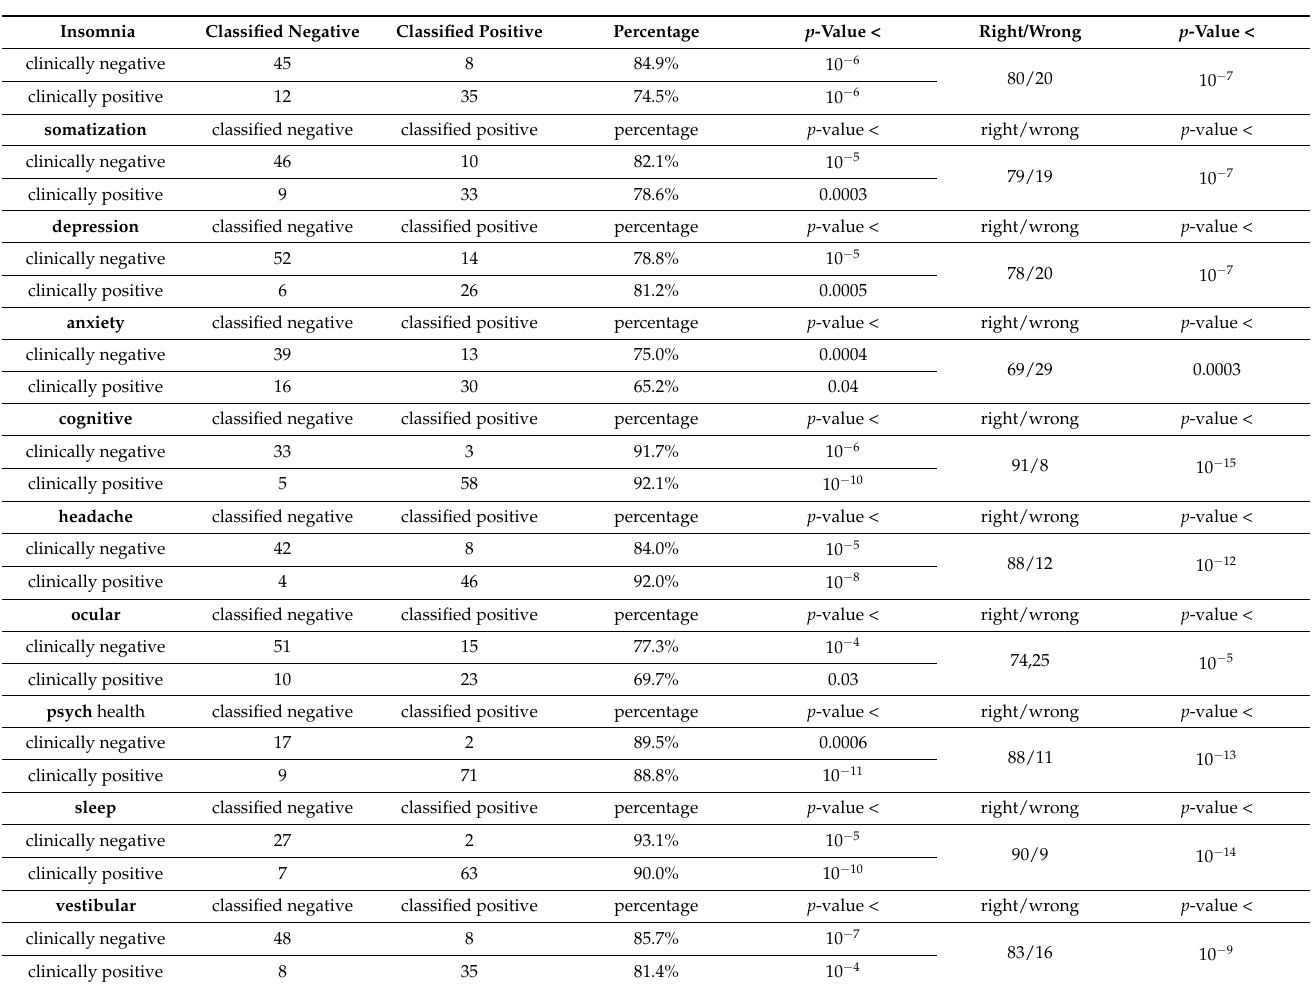
Table 2. Clinical trajectory classification accuracy using regional activation. 136 cortical and ad- jacent white matter regional measures were trained as linear classifiers by group determined by adjudicated clinical trajectory opinions. Jackknifed classification accuracies are shown. Trajectory opinions and regional neuroelectric measures were used from both baseline ( n = 62) and follow-up ( n = 40) sessions for all subjects of the TEAM-TBI cohort. The p-values were obtained using χ 2 with df = 1 (column 5) and df = 2 (column 7). p -values > 0.001 are not reported. The trajectories were coded 0/1. For follow-up trajectories, code was set to 0 if the subject had improved (ocular) or fully recovered (all